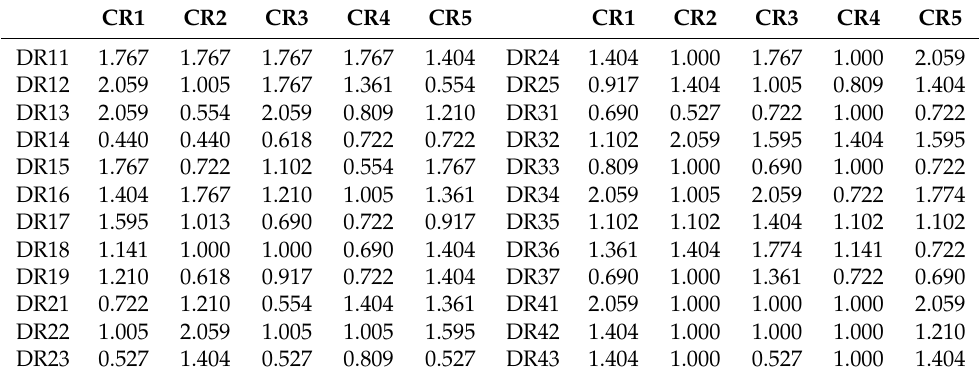
Table 6. Real number correlation matrix between CRs and DRs.